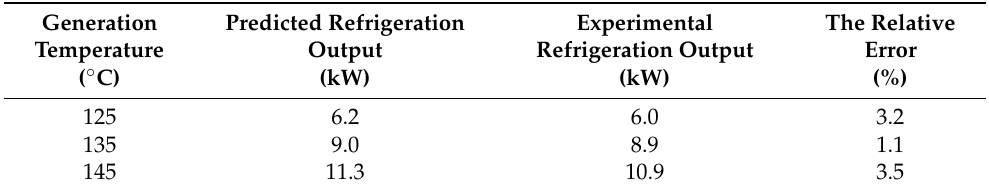
Table 4. Comparison between theoretical and experimental